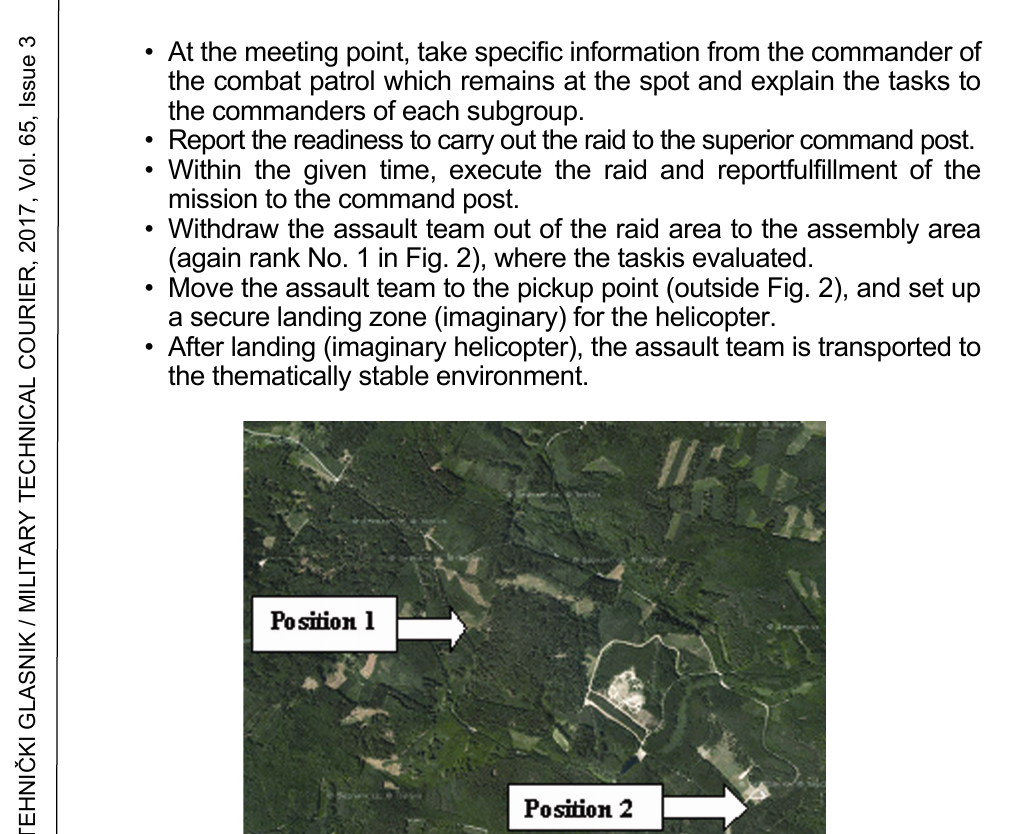
Figure 2 – The raid area Рис . 2 – Пункт